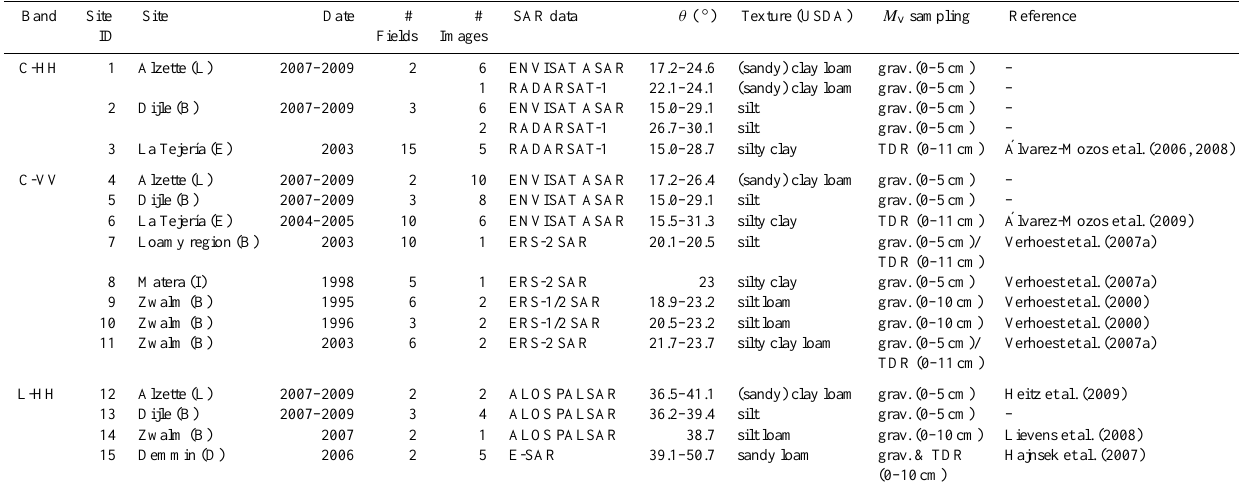
Table 1. Overview of the collected data